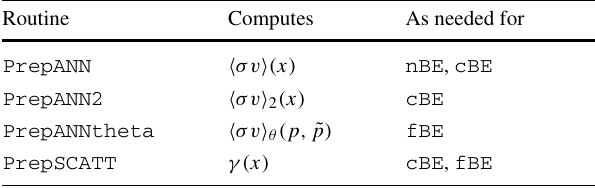
Table 2 The preparatory routines, computing averages of the velocity- weighted annihilation cross-section σv lab . Output of these routine calls is stored in the session memory, such that, e.g., the quantity (cid:8) σv (cid:9) can be used for both nBE and cBE routine calls. These routines are located in rates.wl (in the src/